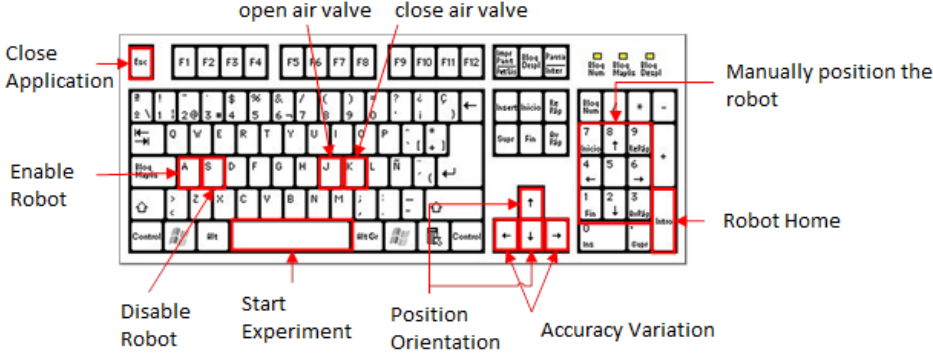
Figure 10. Combination of softkeys and their functionality.